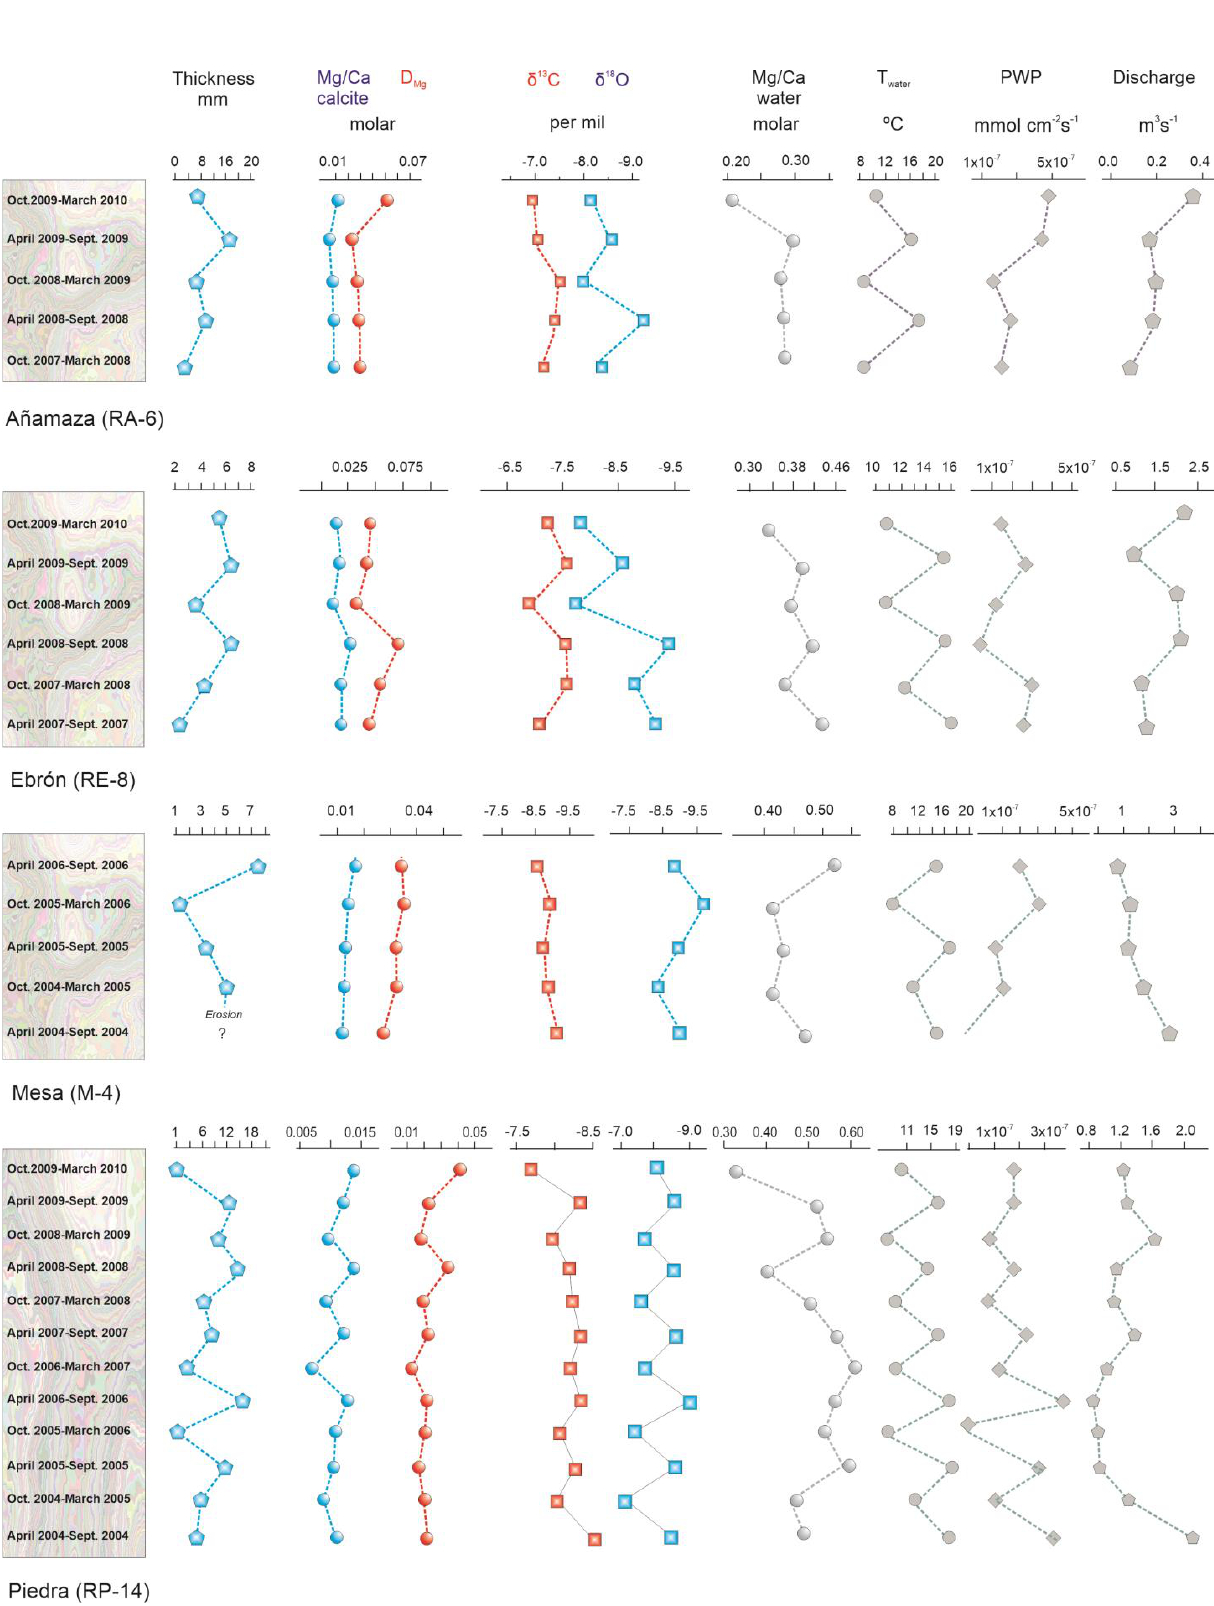
Figure 4. Temporal evolution of some parameters during examined sampling periods in water and stromatolites for the studied tablets. We present temperatures, Mg/Ca ratios, precipitation rates (as PWP values) and discharge values for waters, and six-month accumulated thicknesses, Mg/Ca ratios and δ 18 O and δ 13 C values for stromatolites. We indicate the units in the